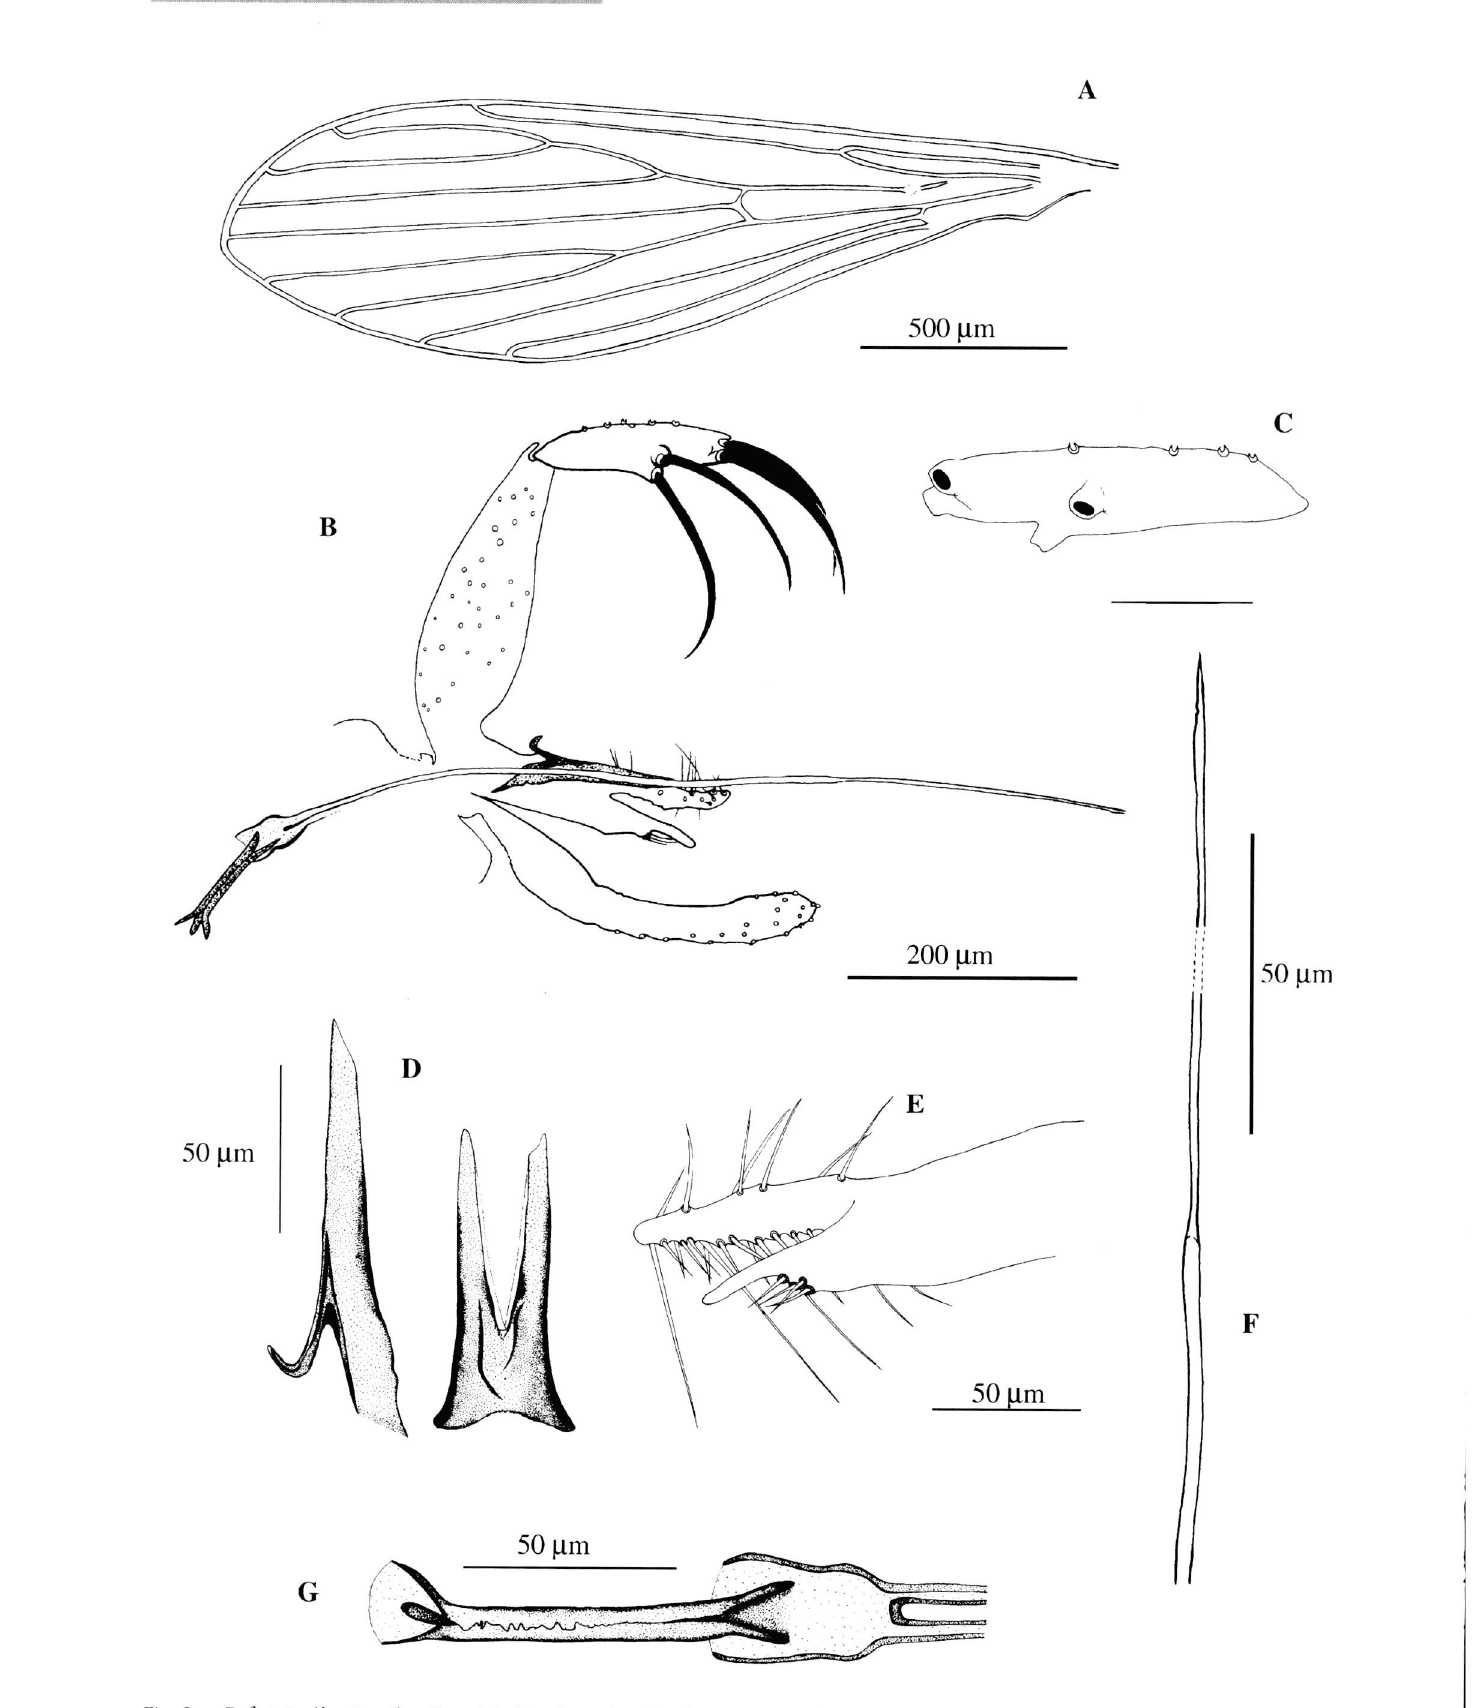
Fig. 2. - P.fertei mâle. A : aile ; B : genitalia ; C : style ; D : clivers aspects de l'édéage (vues latérale et ventrale) ; F : paramère : F : fila ment génital ; G : pompe